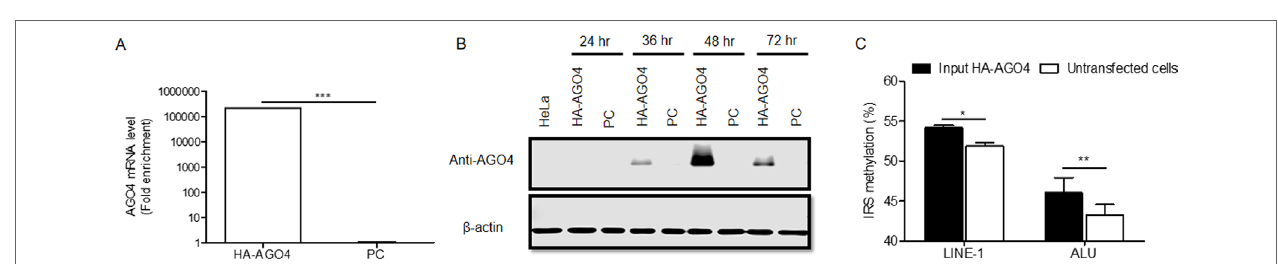
FIGURE 4 | Alu methylation upon Alu siRNA transfection in Tet-controlled AGO4-expressing cells. The Alu methylation level was significantly increased when AGO4 was upregulated under Alu siRNA transfection. The above data are the representative dataset from six independent experiments presented as the mean ± SEM. Statistical analysis was performed using an unpaired t -test where p < 0.01 is represented as **.